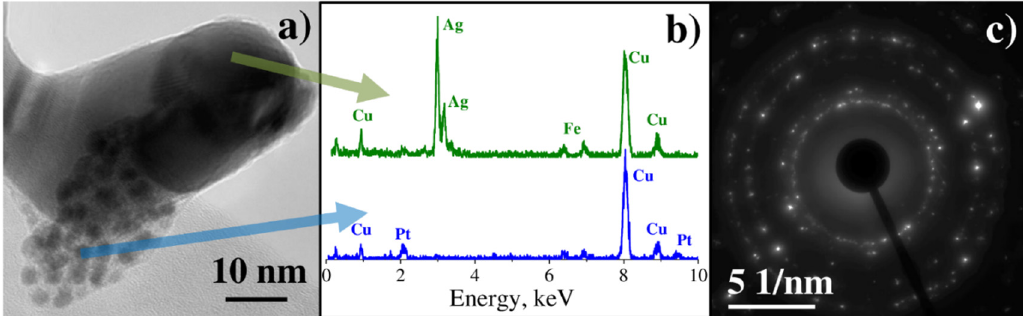
Figure 7. ( a ) Bright-field (BF) TEM image of sample 1-2.1, ( b ) X-ray spectrum from small nanoparticles and spectrum from large nanoparticles, ( c ) electron diffraction pattern.